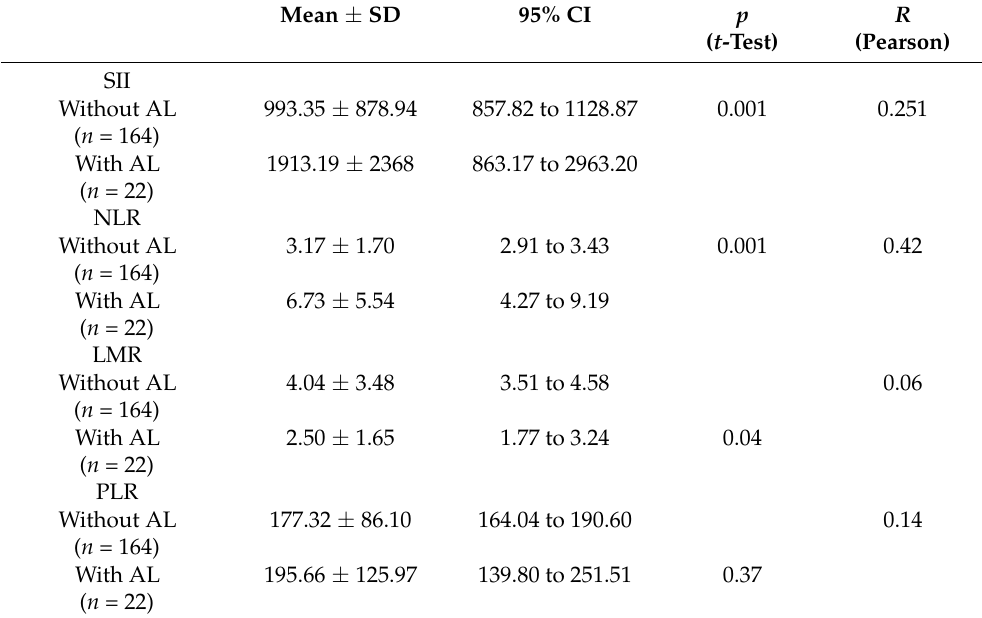
Table 3. Mean values of preoperative immunocyte-derived markers in patients with anastomotic leakage after colorectal cancer